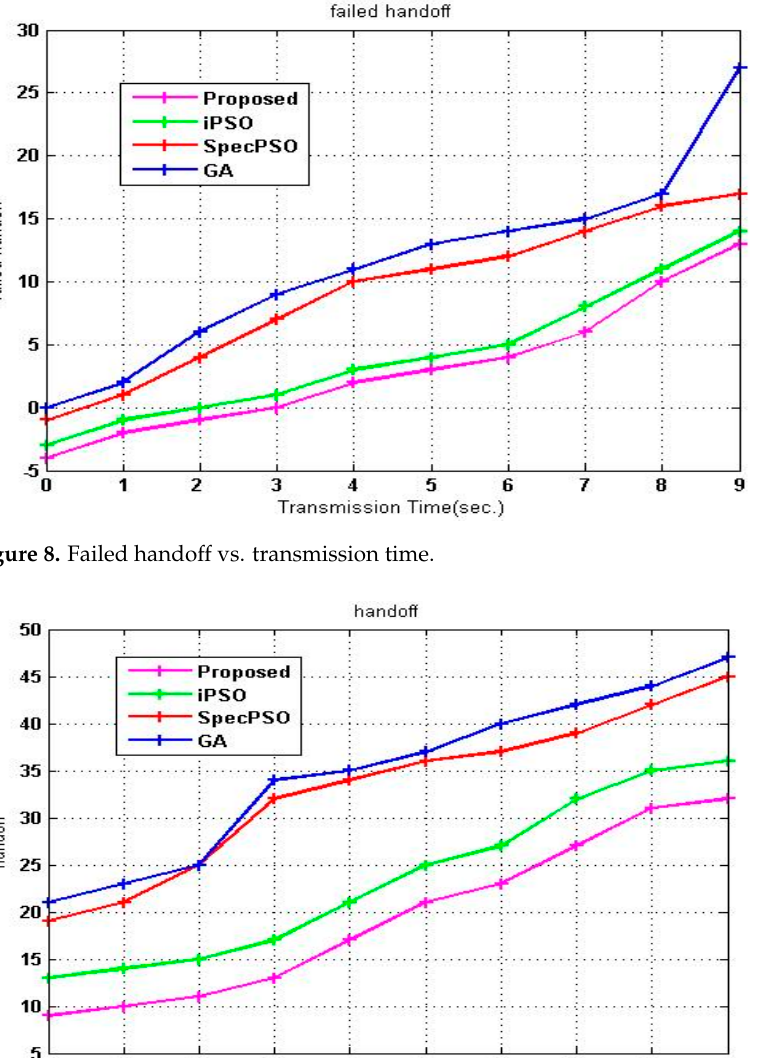
Table 4. Comparison of the SNR on different average E b /N 0 values for various handoff algorithms. Average E b /N 0